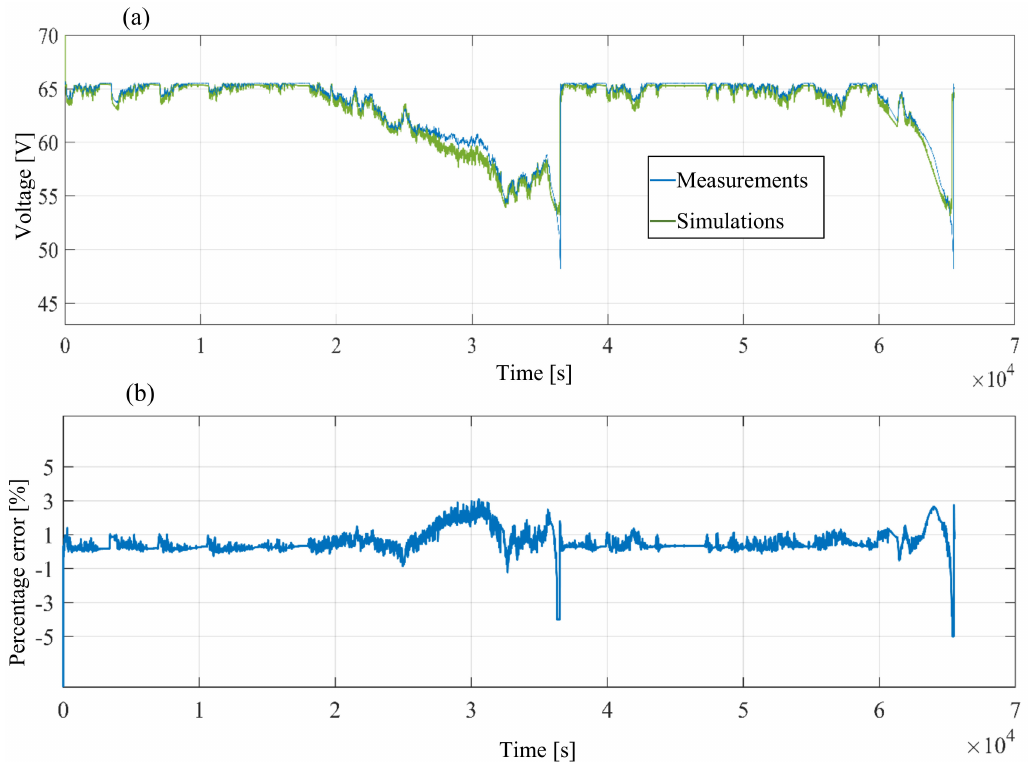
Figure 6. ( a ) Comparison between measurements and model results for the 15th and 16th aging cycles; ( b ) Model percentage error.